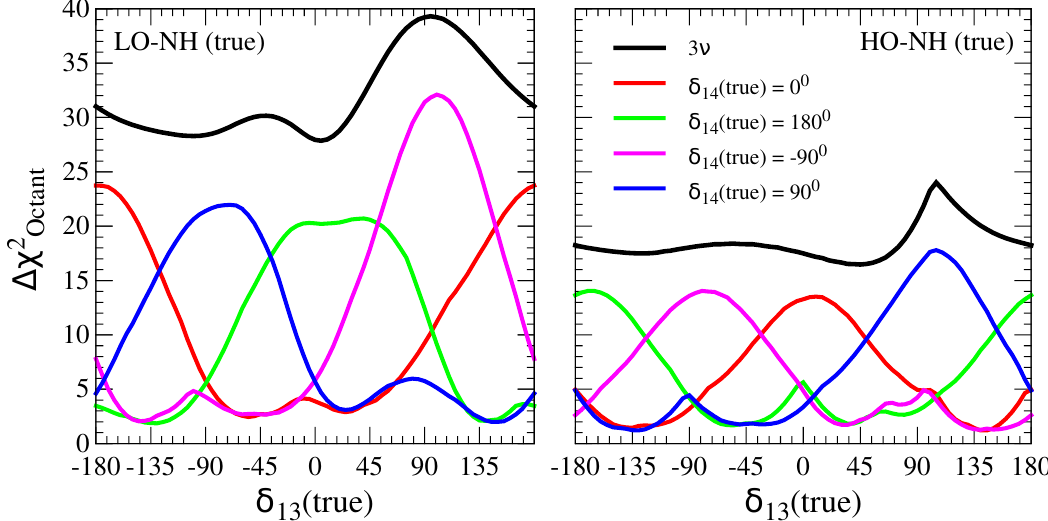
Figure 8. Sensitivity to the octant of θ 23 as a function of true δ 13 for LO-NH ( left ) and HO-NH ( right ) as the true option. We take sin 2 θ 23 = 0.42(0.58) as representative value for LO (HO). In each panel, we present the results for the 3-flavor scenario (black line), and for the 3 + 1 case we consider four different values of true δ 14 (colored lines). Figure taken from